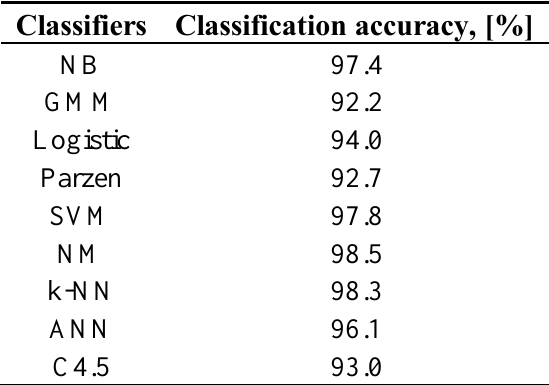
Table 5. Single-frame classifier performance.